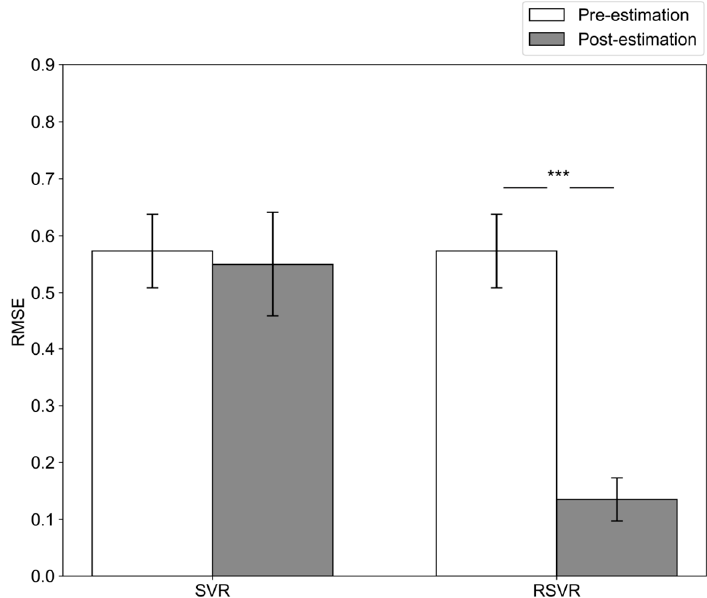
Figure 5. Statistical analysis of the RMSE of pre- and post-trial estimation performed using SVR (without proposed method) and RSVR (with proposed method) (***: p < 0.001, **: p < 0.01, *: p < 0.05).